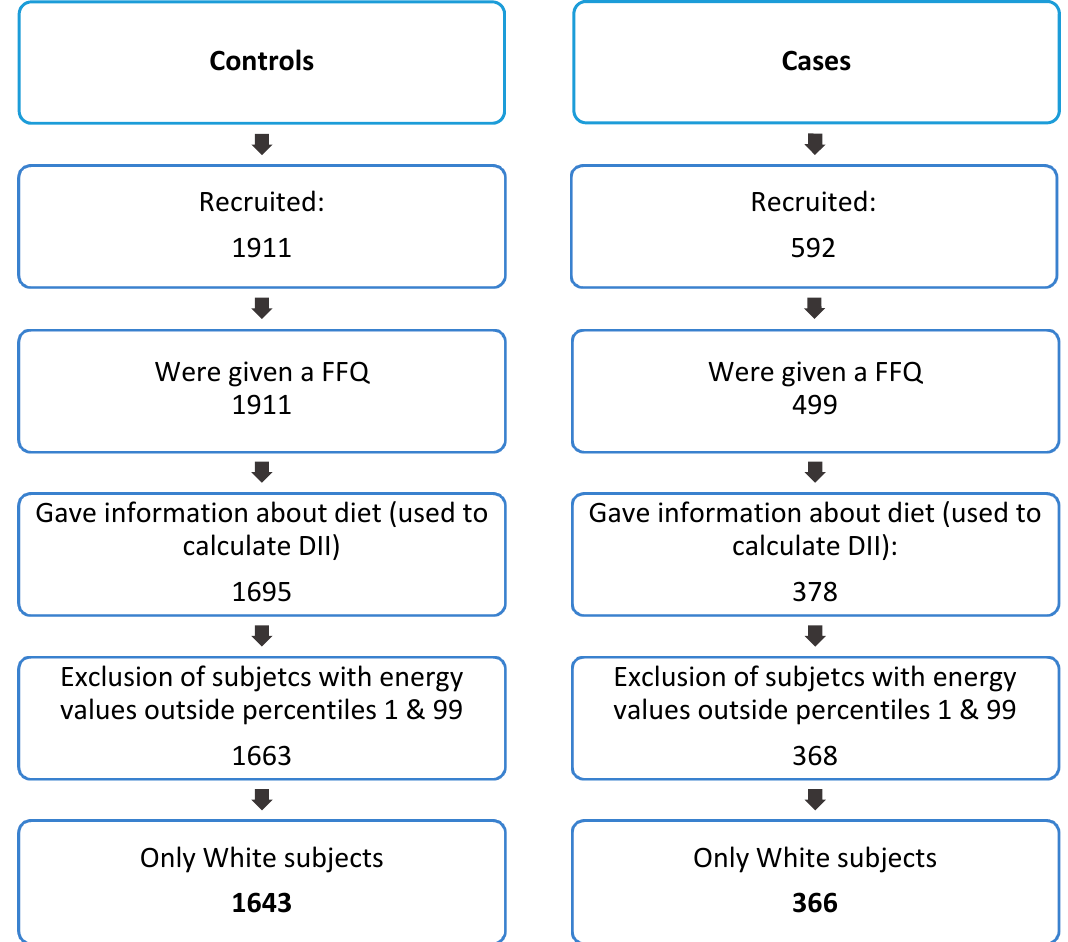
Figure 1. Flow chart of the population of the study .